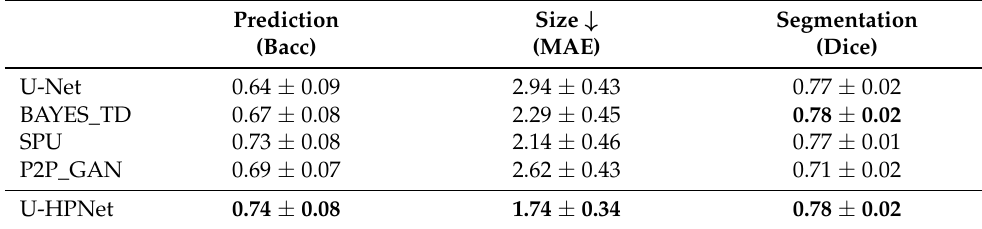
Table 5. Performance comparison with alternative networks for tumour growth using the estimated